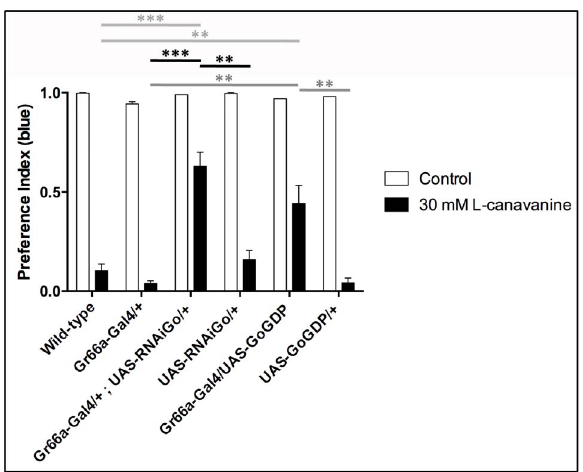
Figure 4. L-canavanine aversion is reduced when bitter- sensitive taste neurons express a RNAi construct against G a o47A or a dominant negative form of G a o47A. Two-choice feeding test experiments showing preference index (PI) for the blue solution of different genotypes. Control (white bars) and 30 mM L- canavanine (black bars) indicate that no drug or 30 mM L-canavanine was added to the blue solution, respectively. A complete preference or aversion is indicated by a PI value of 1 or 0, respectively. The down regulation of G a o47A by RNA interference (Gr66a-Gal4/ + ;UAS-RNAiGo/ + ) and the inhibition of G a o47A by using a dominant negative construct (Gr66a-Gal4/UAS-Go GDP ) reduced the aversion to L-canavan- ine compared to controls (wild-type, Gr66a-Gal4/ + , UAS-RNAiGo/ + and UAS-Go GDP / + ). Note that all genotypes did not show any defect for sugar detection. Error bars indicate SEM. Asterisks indicate significant differences by Unpaired Student’s t test (** p , 0.01, *** p , 0.001).